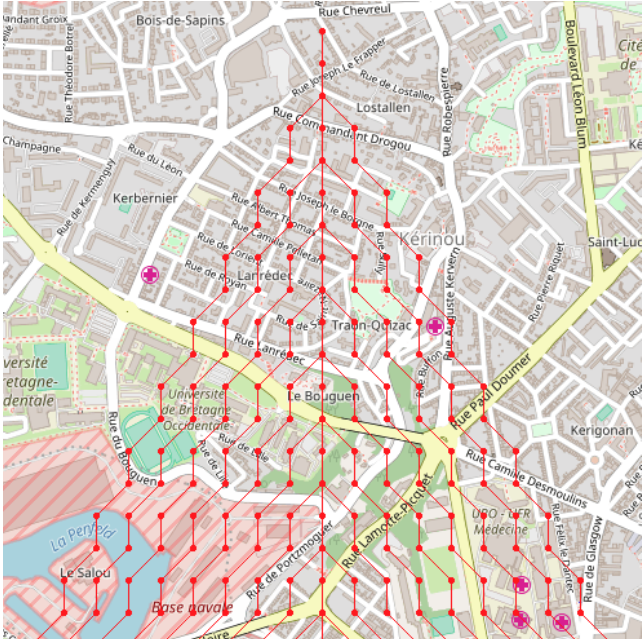
Figure 16. Directed BSF is a distributed parallel algorithm able to manipulate data on grid cells. Its aim is to mimic point-to-point radio links adopting the LoS condition. Segmented lines are laid on a map to represent how cells forward incoming signal gradually from a root cell ( x = 10, y = 1) to definite